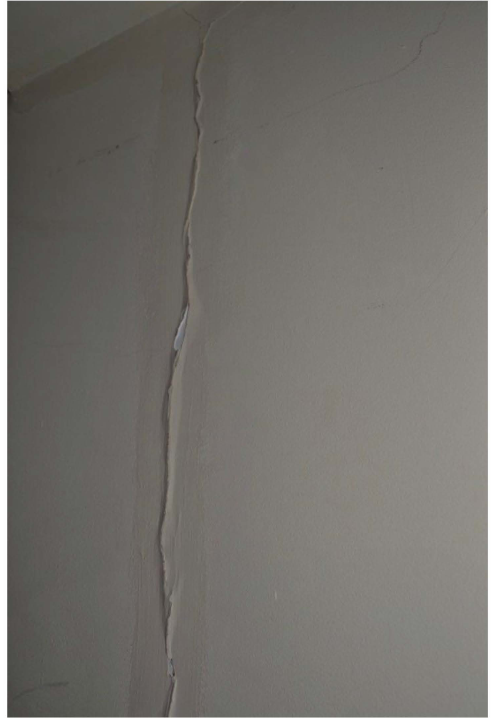
Figure 14. House visit.